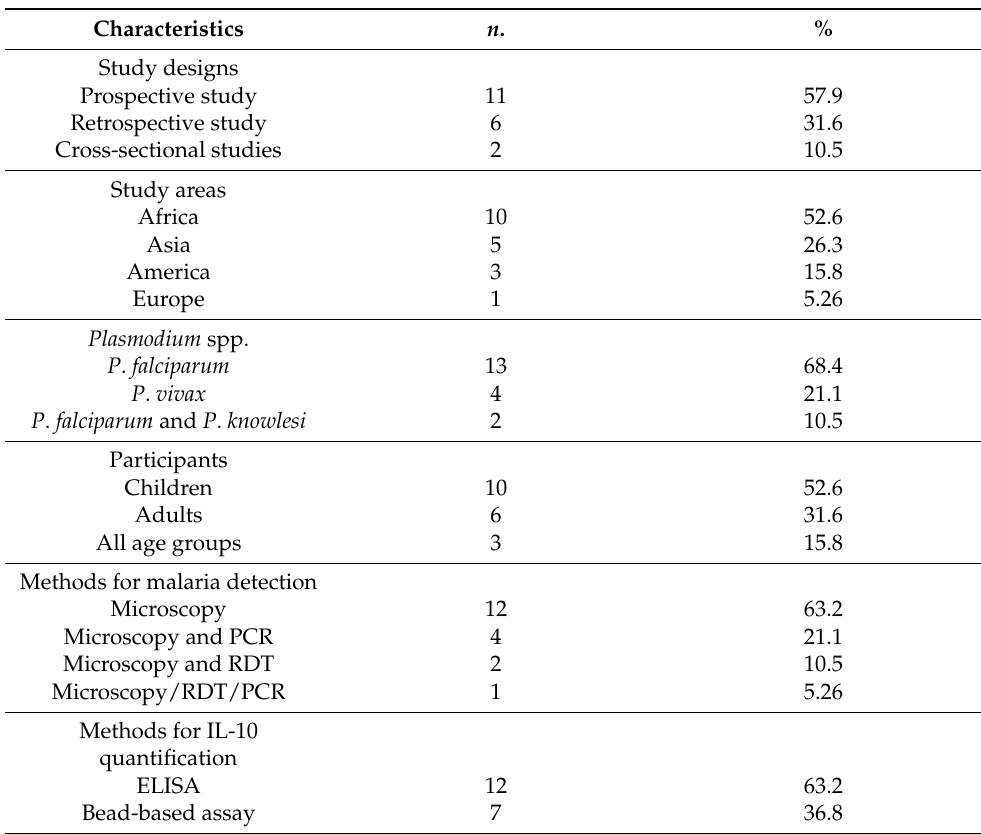
Table 1. Characteristics of the included